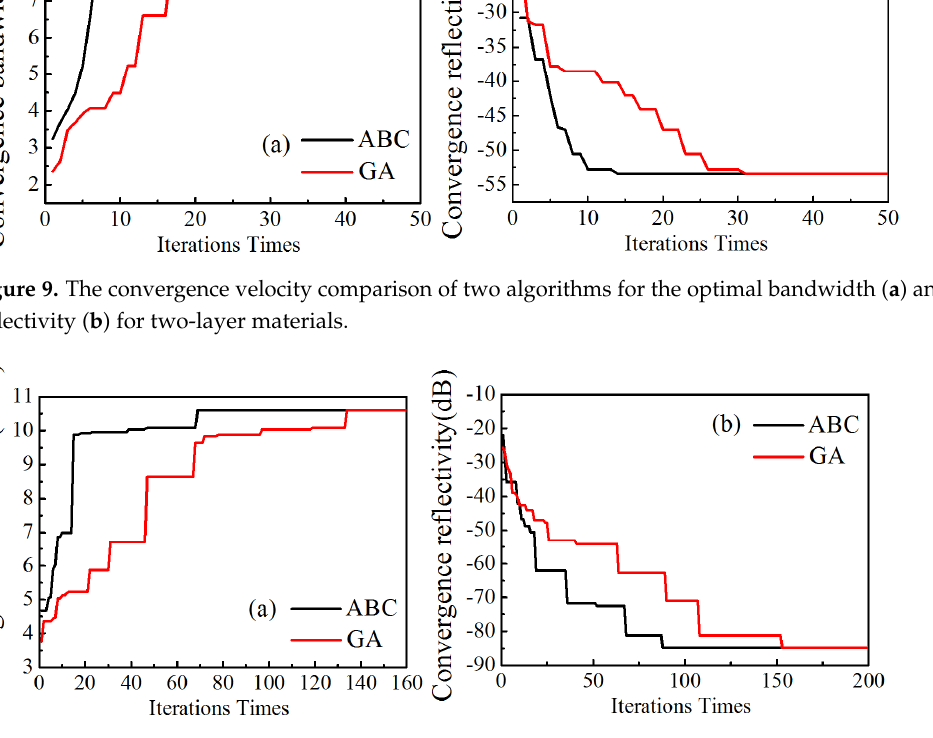
Figure 9. The convergence velocity comparison of two algorithms for the optimal bandwidth ( a ) and reflectivity ( b ) for two-layer materials.